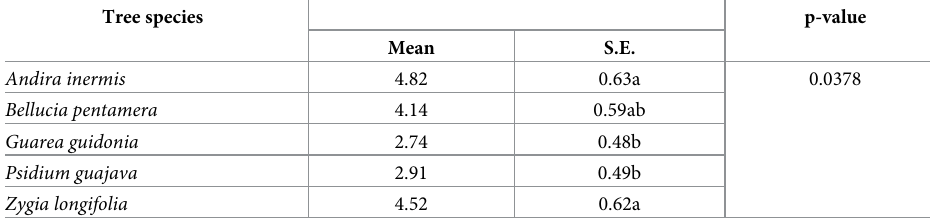
Equal letters between species indicate equal means (P >